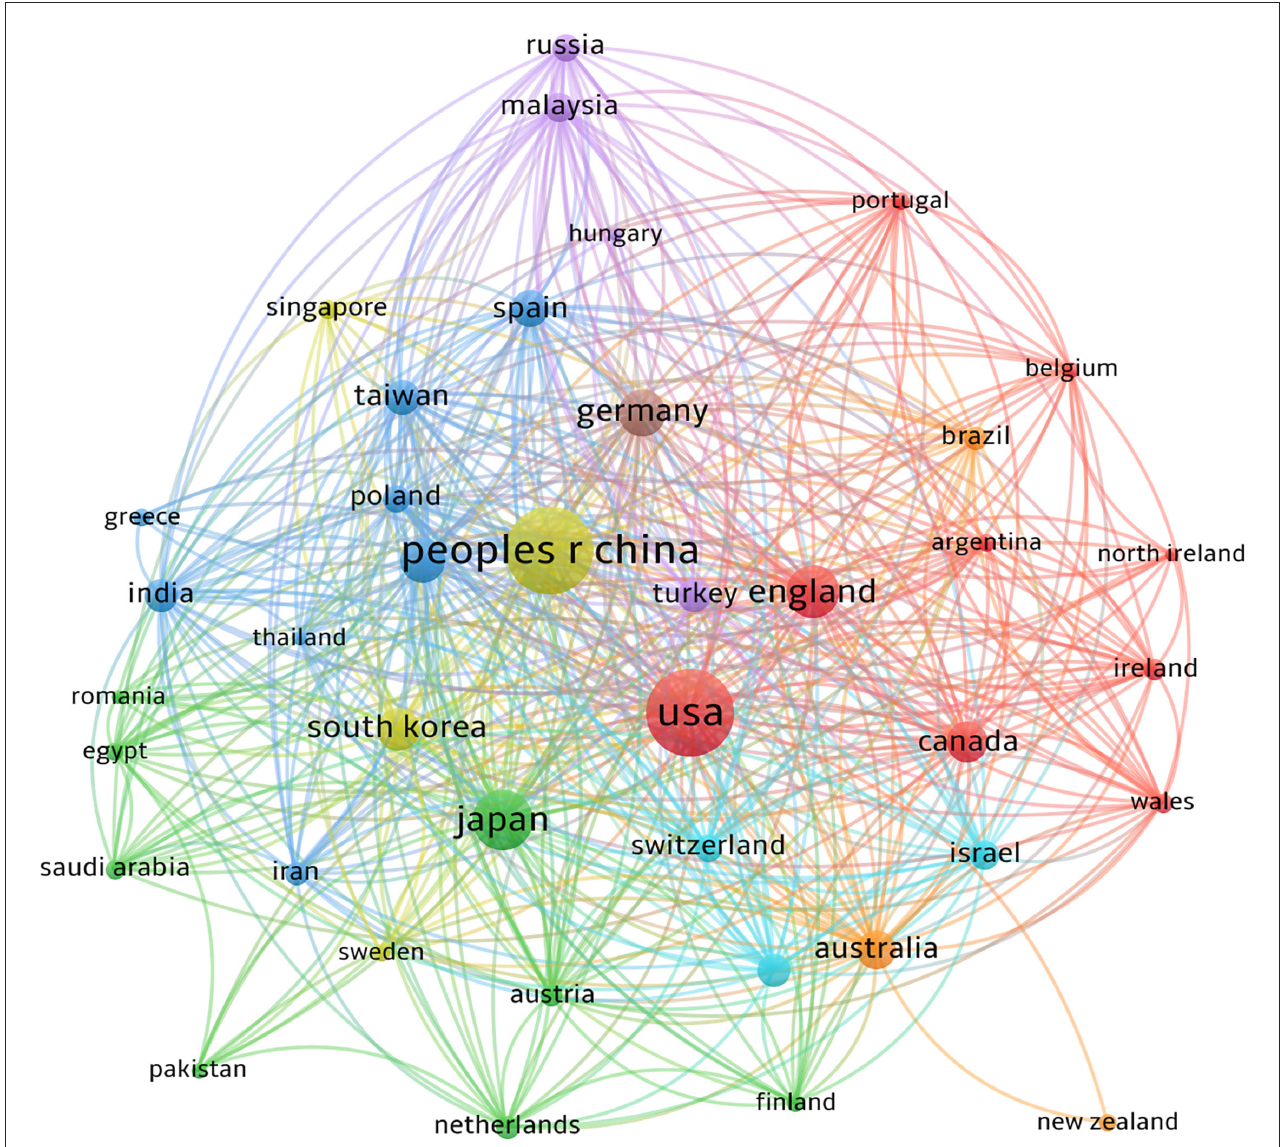
FIGURE3 A total of 56 countries or regions have participated in the study of apoptosis in glaucoma. China and the United States are at the center of the study. The red cluster is centered in the United States. China’s cooperation between countries and regions is relatively weak.